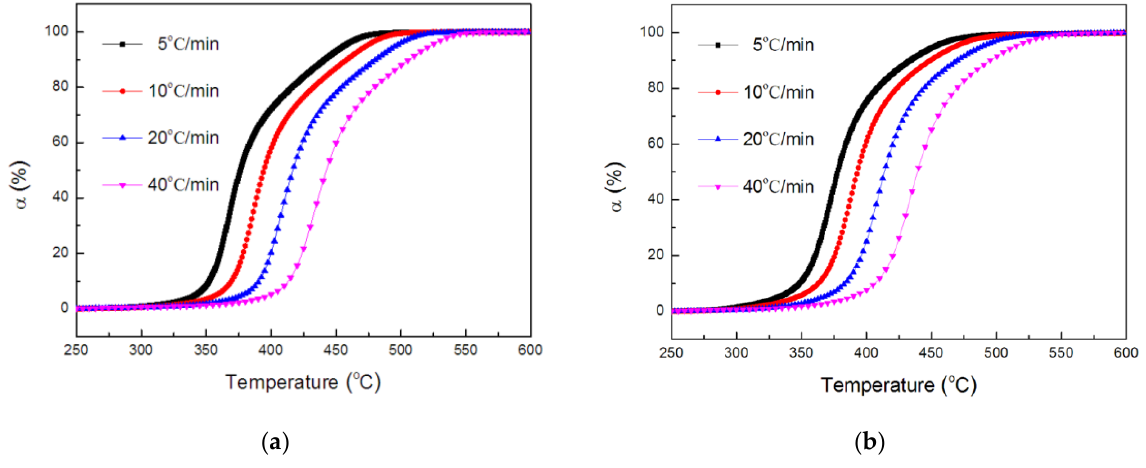
Figure 8. Conversion of TE ( a ) and FRTE ( b ) as a function of temperature.